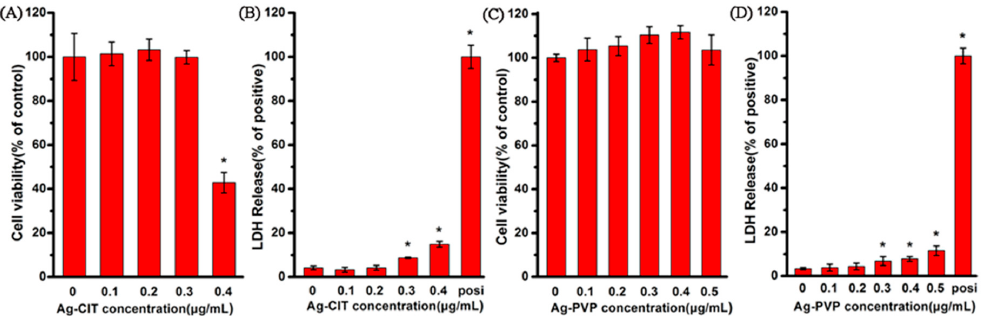
Figure 9. The viability assay and LDH levels of Caco-2 cells after exposed to Ag-CIT ( A , B ) and Ag-PVP ( C , D ) for 21 days. ( A , C ) Percent viable cells compared to the no particle (0 μ g/mL) condition. ( B , D ) Percent LDH release compared to 100% cell lysis. All data are represented as the mean ± SD ( n = 6). * p < 0.05 comparing with the 0 μ g/mL control.